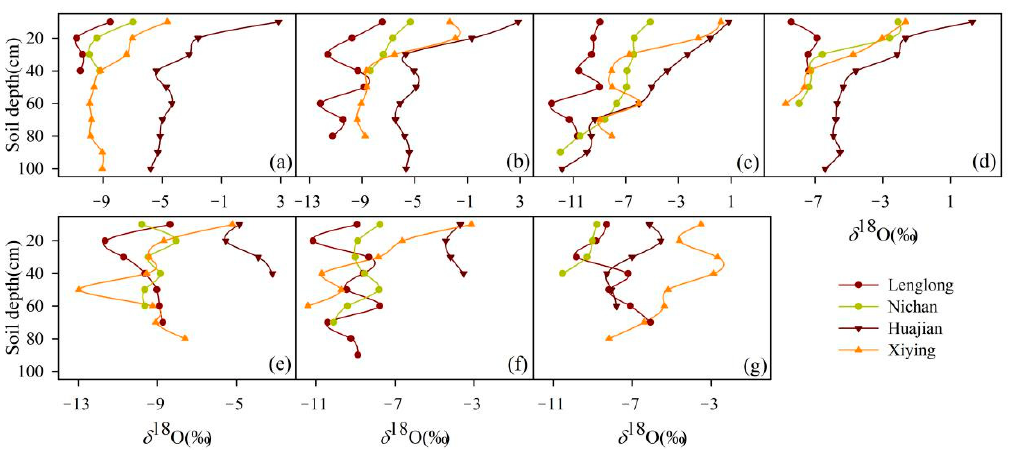
Figure 5. Profile variation of soil water δ 18 O at the four stations in the study area (( a ) Apr; ( b ) May; ( c ) Jun; ( d ) July; ( e ) Aug; ( f ) Sept; ( g ) Oct).